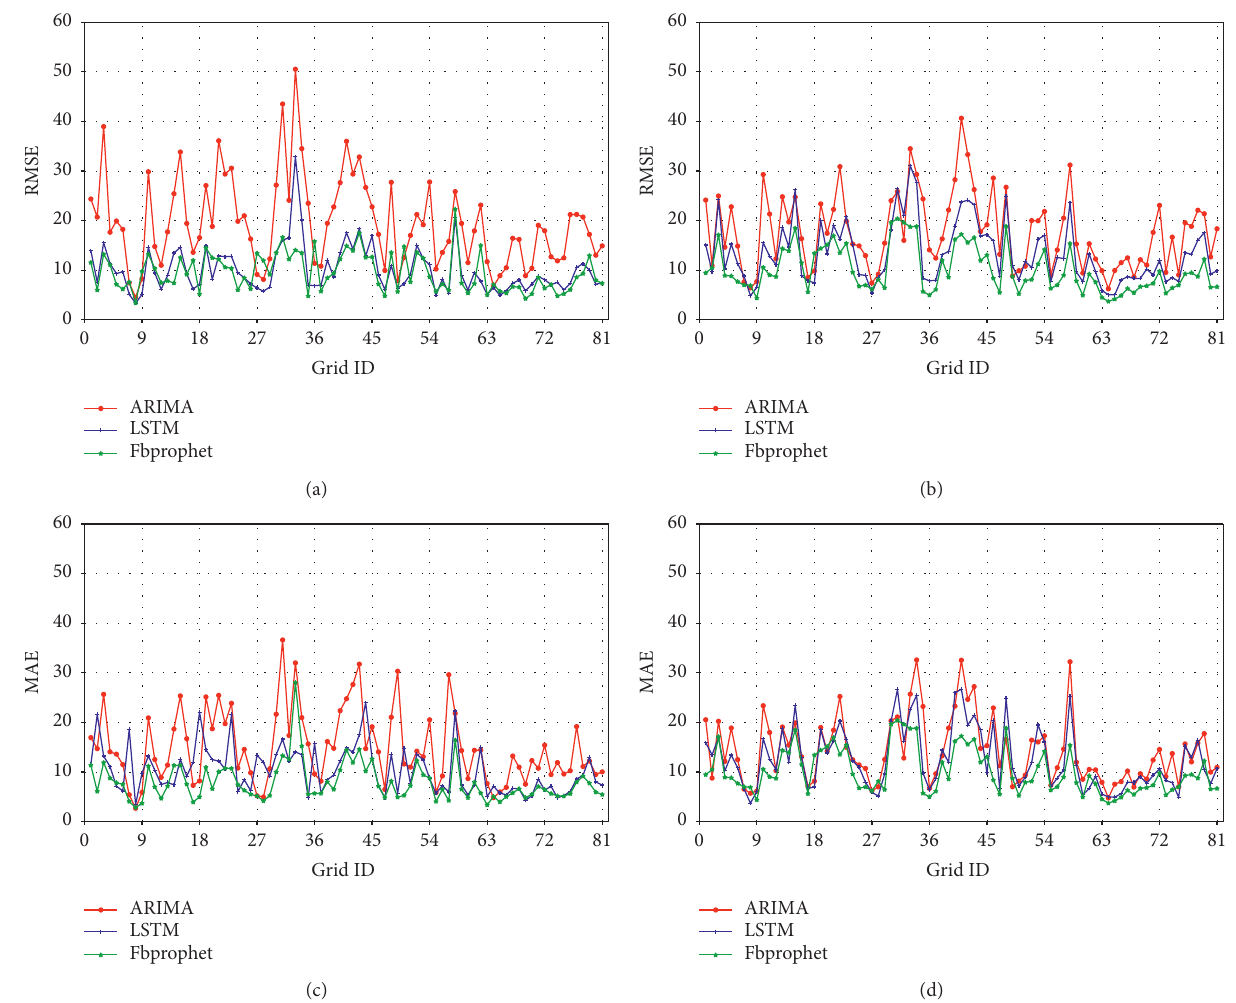
Figure 5: Comparison of the results of three methods under different indicators in different time periods. (a) RMSE-weekdays. (b) RMSE- weekends. (c) MAE-weekdays. (d)